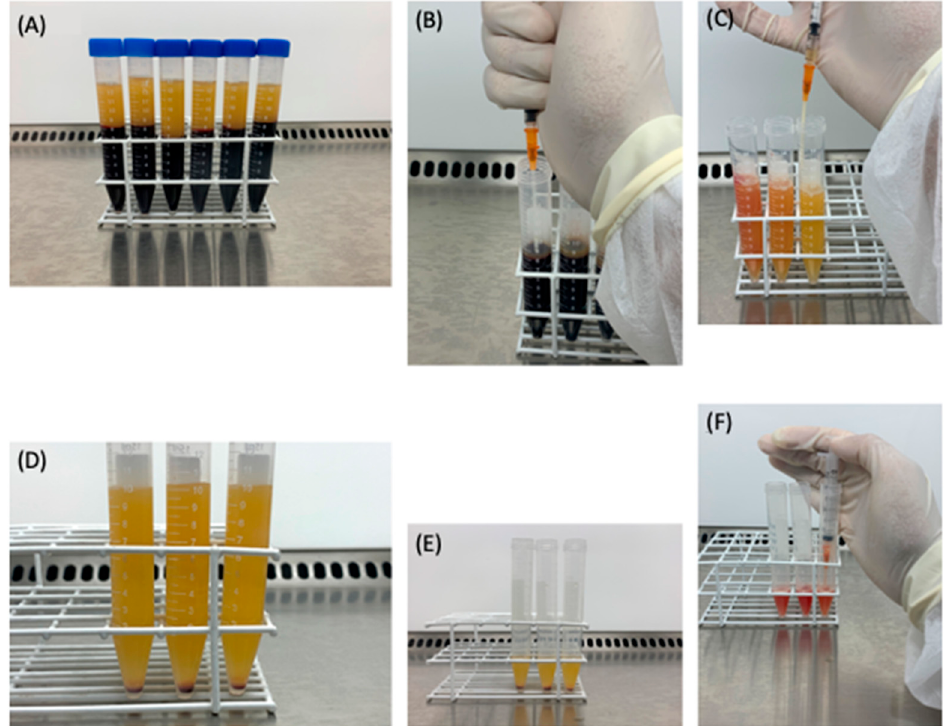
Figure 1. Processing of the LR-PRP. ( A ) Separation of the blood components, resulting from the first centrifugation; ( B ) Collection of the plasma and buffy coat; ( C ) Plasma and buffy coat, added in another falcon tube; ( D ) Buffy coat-containing pellet after the second centrifugation; ( E ) Twenty percent of the bottom layer, representing the LR-PRP; ( F ) Homogenized LR-PRP.